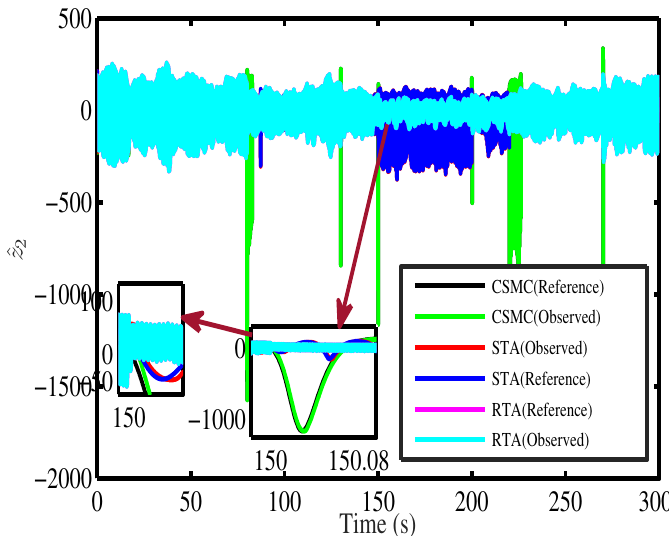
Figure 6. Z 2 tracking in the varying load and varying inertia case.